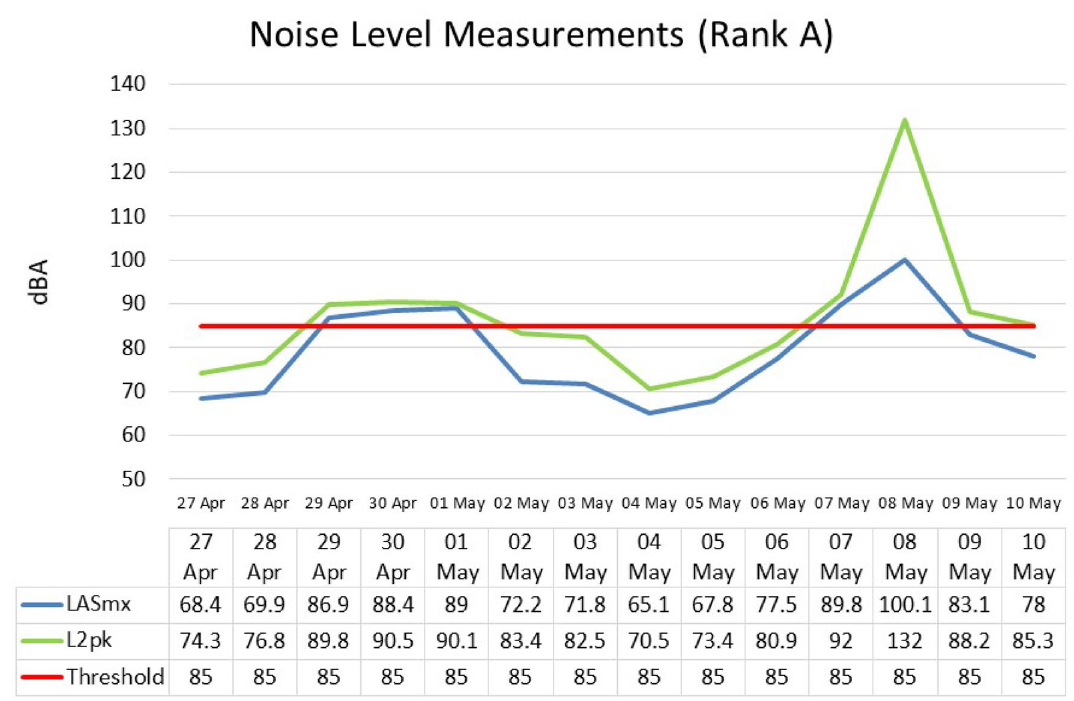
Figure 4. Noise measurements for